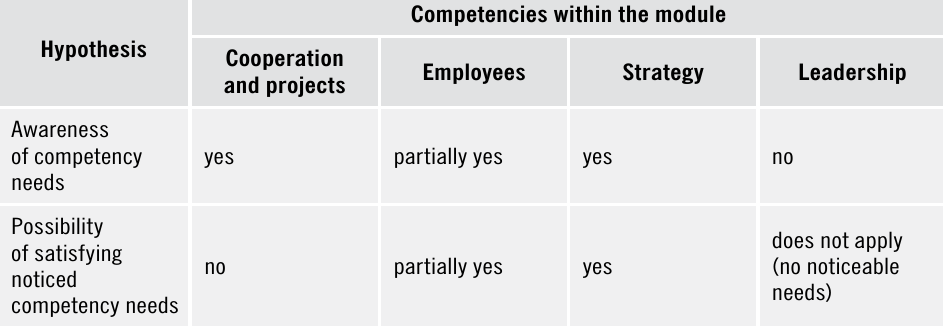
Table 4. Verification of hypotheses: a summary Competencies within the module Hypothesis Cooperation Employees Strategy and projects